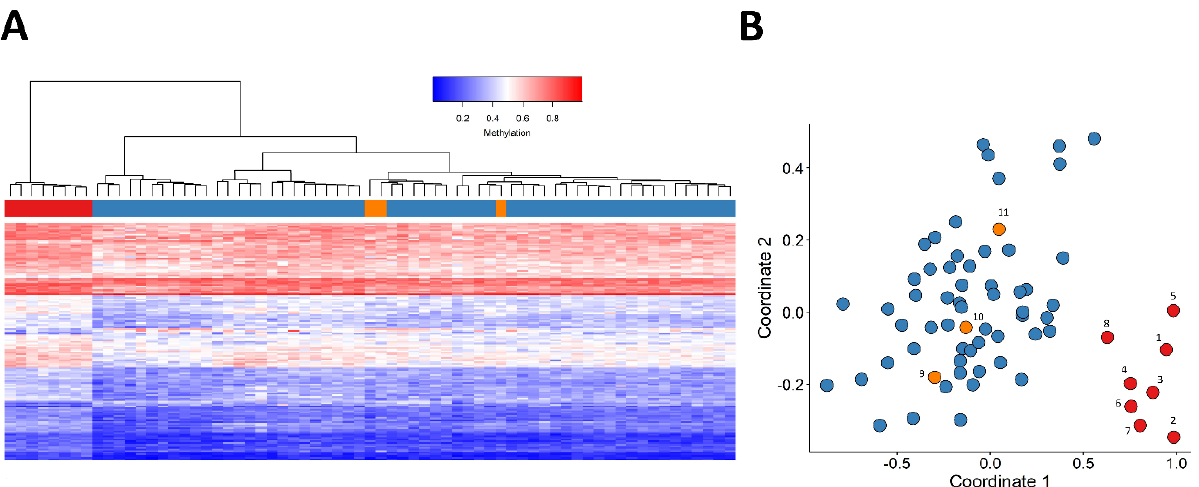
Figure 3. Adding patients 9 − 11 as a testing sample to the unsupervised clustering models. In both figures, individuals depicted in red (patients 1 − 8) and blue (control samples) were used for feature selection, and individuals indicated with orange (patients 9–11) were not used for selecting probes. ( A ) Hierarchical clustering, ( B ) Multidimensional scaling (MDS) plot, X -axis represents coordinate 1 and Y -axis represents coordinate 2. Patients and control samples (depicted in red and blue, respectively) clearly cluster separately. The samples with JARID2 VUS (orange) clustered together with controls.